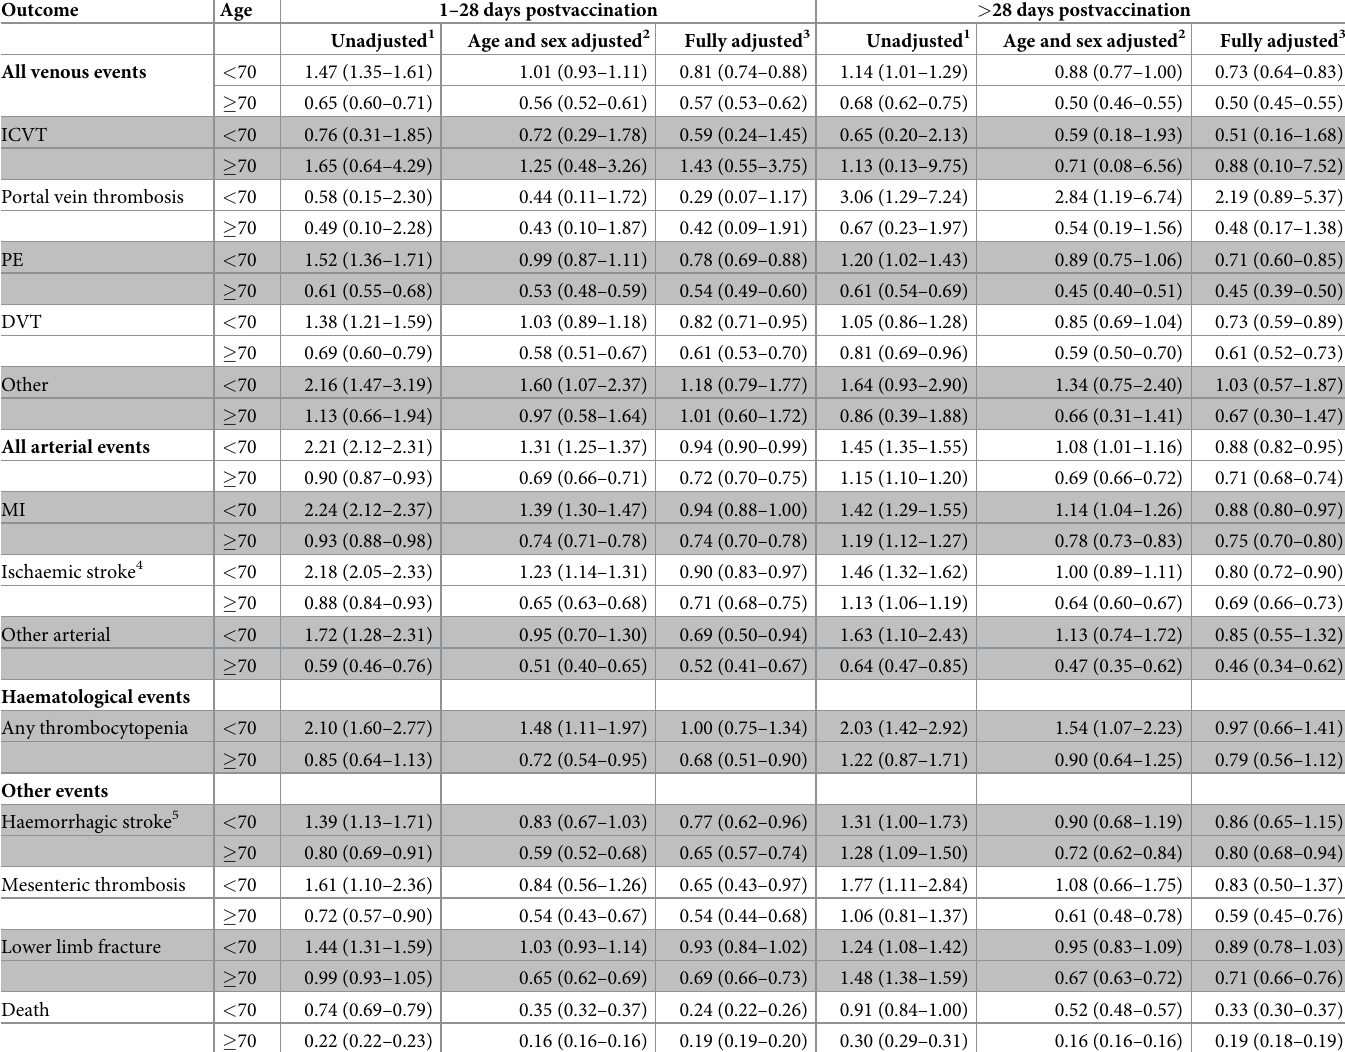
Table 5. HRs (95% CIs) for thrombotic and other outcomes 1–28 and > 28 days postvaccination with BNT162b2 vaccine, compared with prevaccination rates. All analyses were stratified on geographical